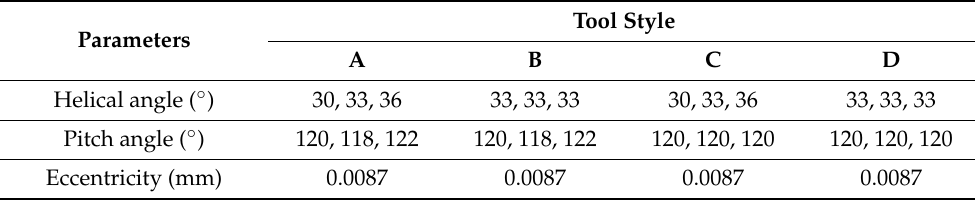
Table 1. Tool design